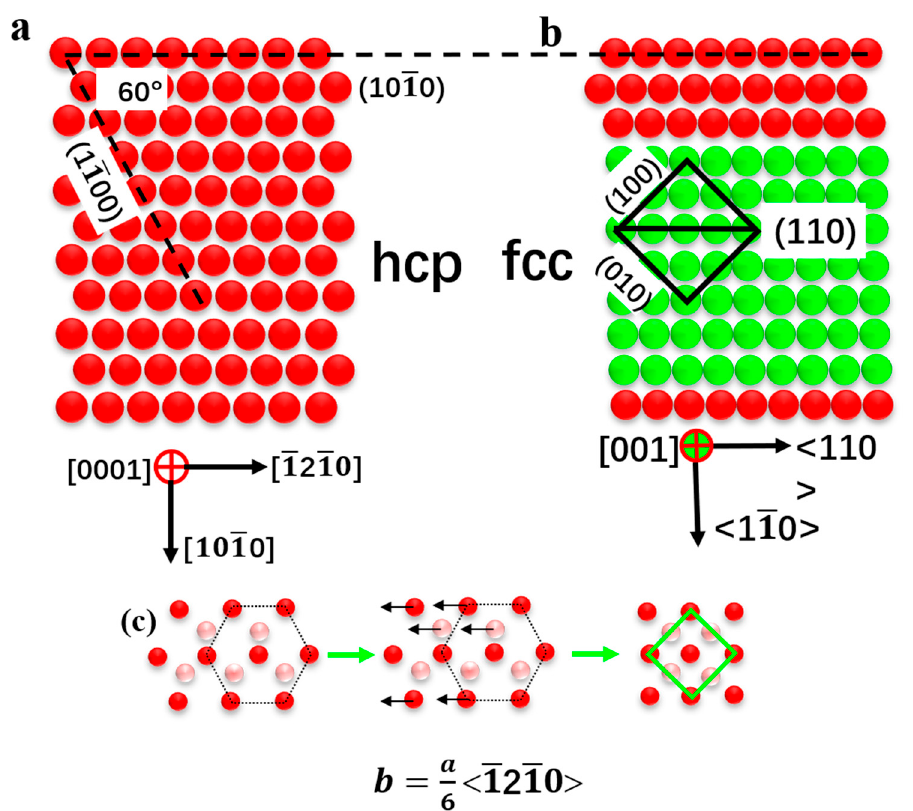
Figure 4. Schematic of HCP → FCC phase transient. ( a ) HCP-Ti phase structure; ( b ) FCC-Ti phase structure; ( c ) HCP to FCC phase transient by Shockley partial dislocation.